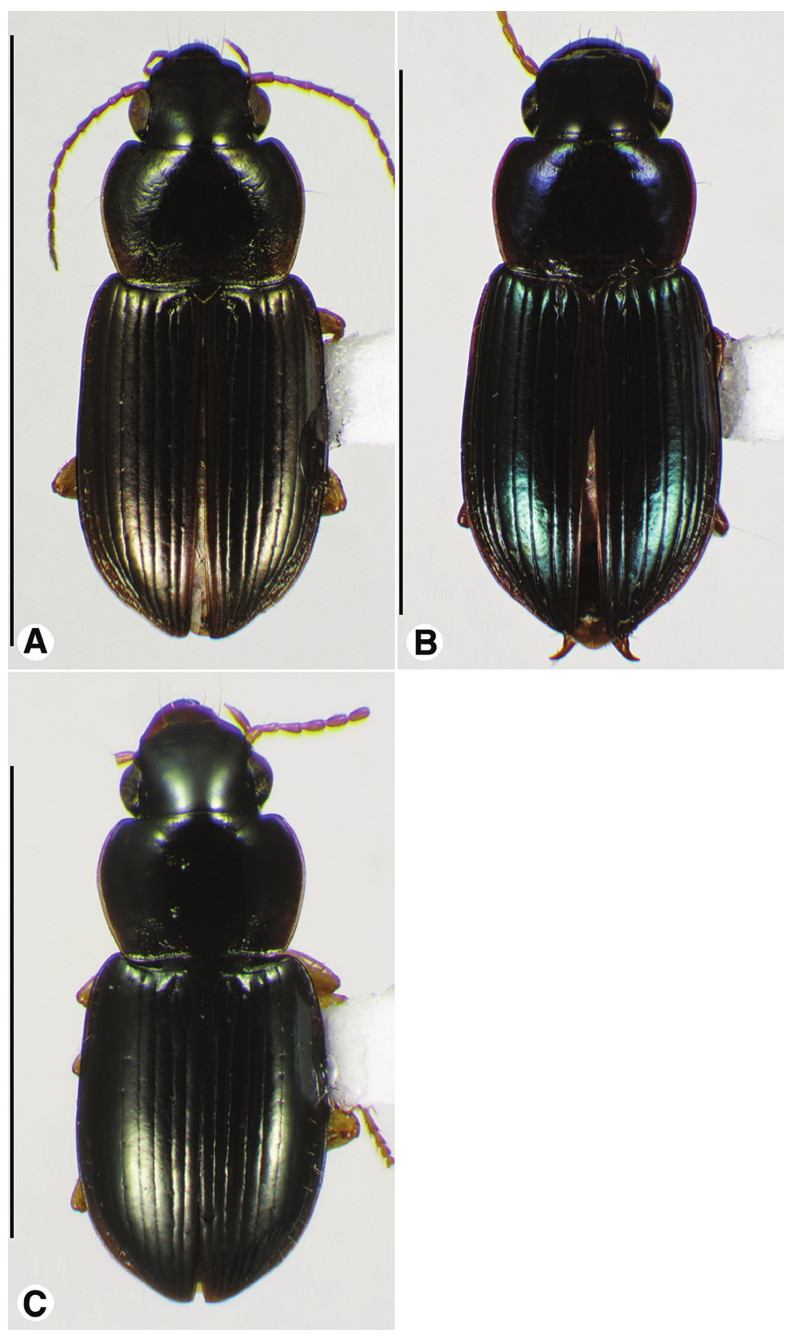
Figure 31. Habitus digital images of Selenophorus mundus species group, dorsal aspect. A S. mundus Putzeys B S. paramundus Ball & Shpeley C S. pseudomundus Ball & Shpeley. Scale bars: A, B 5 mm C 3